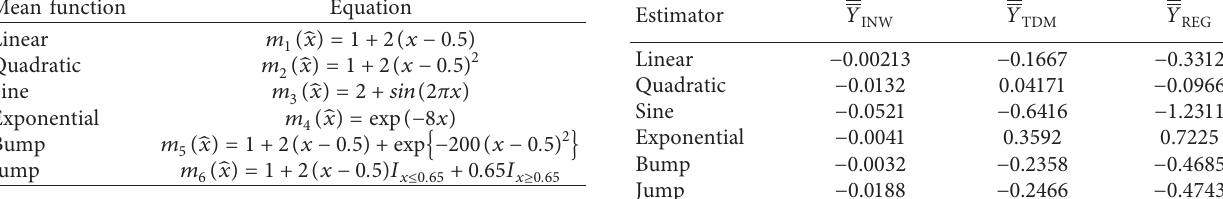
Table 1: Equations of mean functions simulated. Mean function